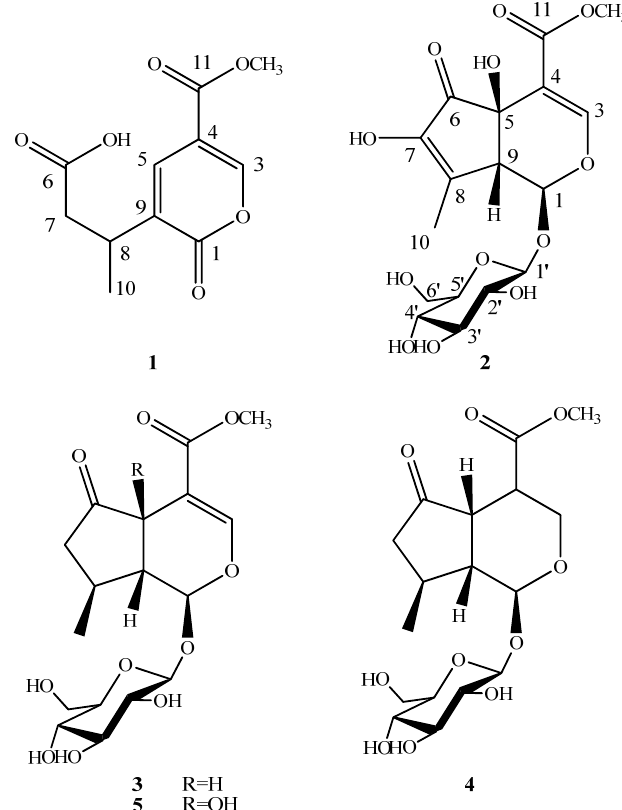
Figure 1. Structures of compounds 1 – 5